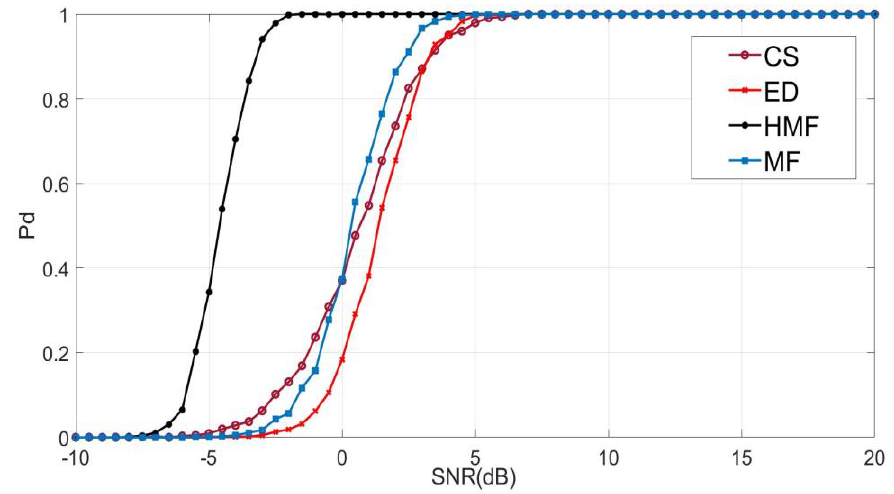
Figure 12. Pd and SNR for Rician channel.